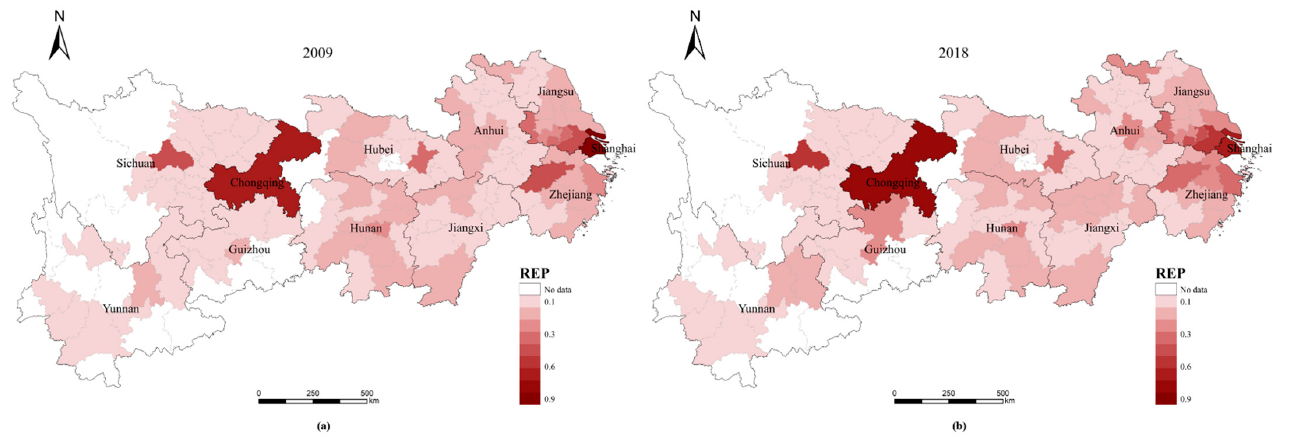
Figure 5. RES index of cities at different administrative levels in 2009 and 2018.